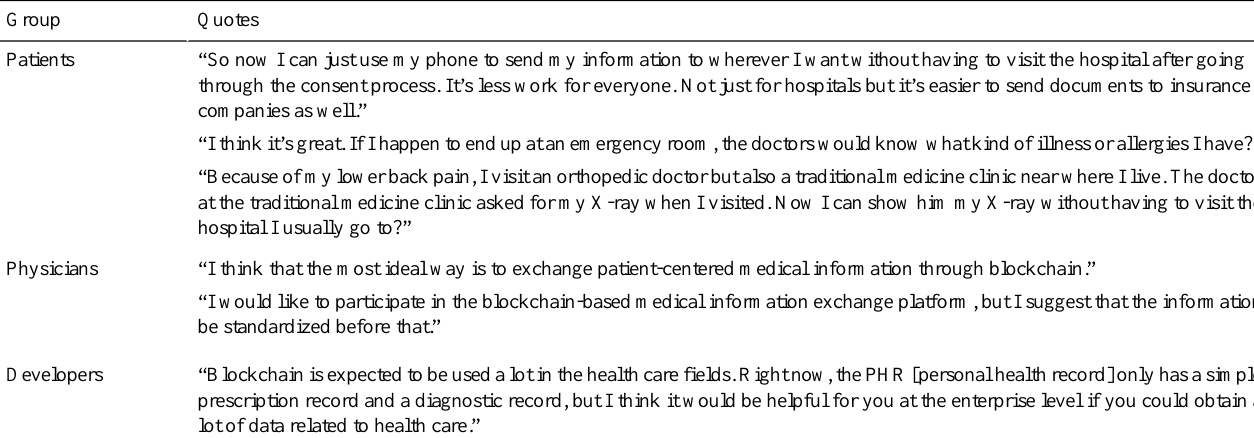
Table 5. Attitudes on blockchain-based patient-centered hospital information exchange